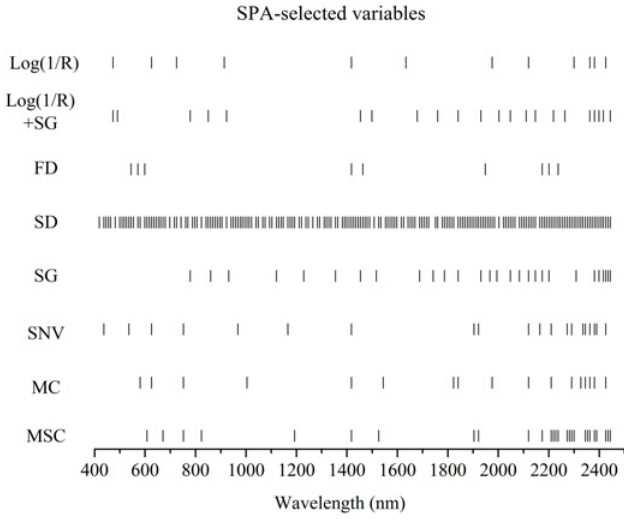
Figure 3. The selected variables (indicated by the | markers) by the successive projections algorithm (SPA) with the eight pre-processing methods ( i.e. , Log (1/R), Log (1/R) coupled with Savitzky–Golay (SG) smoothing (Log (1/R) + SG), first derivative with SG smoothing (FD), second derivative with SG smoothing (SD), SG, standard normal variate (SNV), mean center (MC) and multiplicative scatter correction